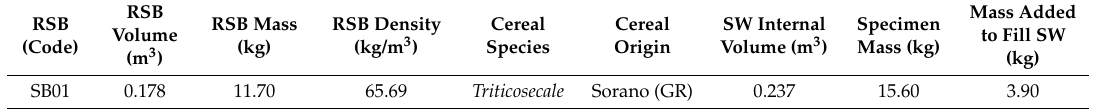
Table 5. Dimensions and density of the RSB and of the specimen.